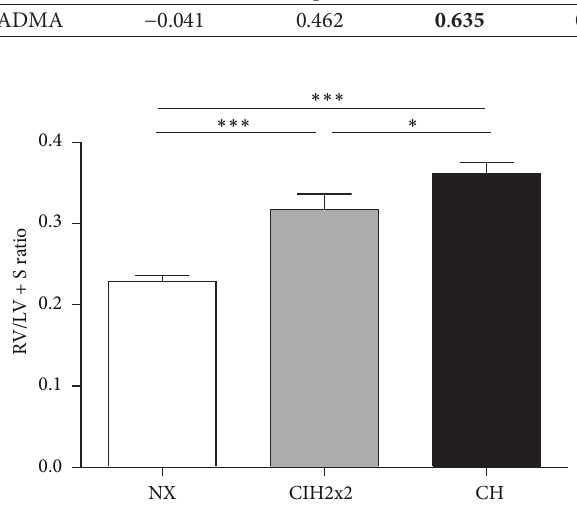
Figure 1: Right ventricle hypertrophy weight (g) ratio (RV/LV + S (right ventricular/left ventricular + septum)) of rats exposed to normoxia (NX), chronic intermittent hypoxia (CIH2x2), or chronic hypoxia (CH). Values are expressed as means and standard errors (SE). ∗ 𝑝 < 0.05 ; ∗∗∗ 𝑝 < 0.001 ; 𝑛 = 8 in each group.